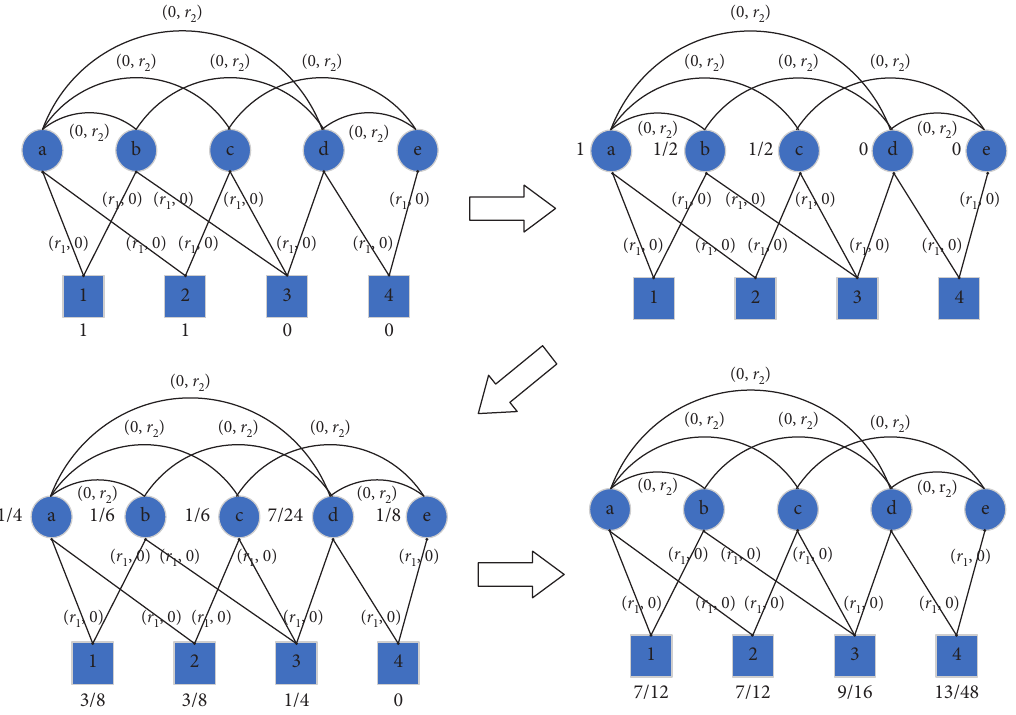
Figure 3: The diffusion process of SDM1 algorithm.